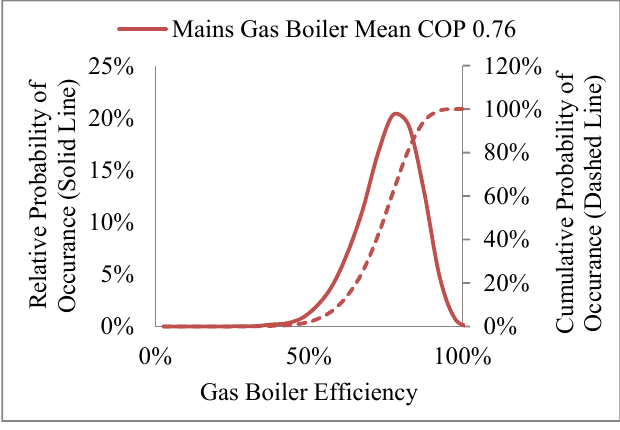
Figure 3. Gas boiler MC performance input distribution.